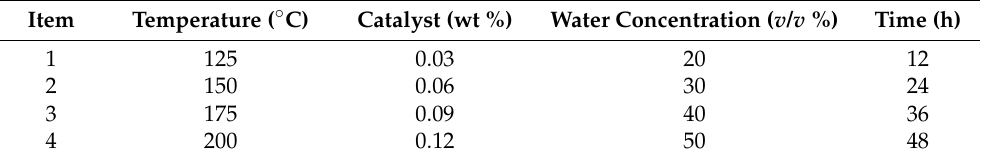
Table 2. Orthogonal factors of